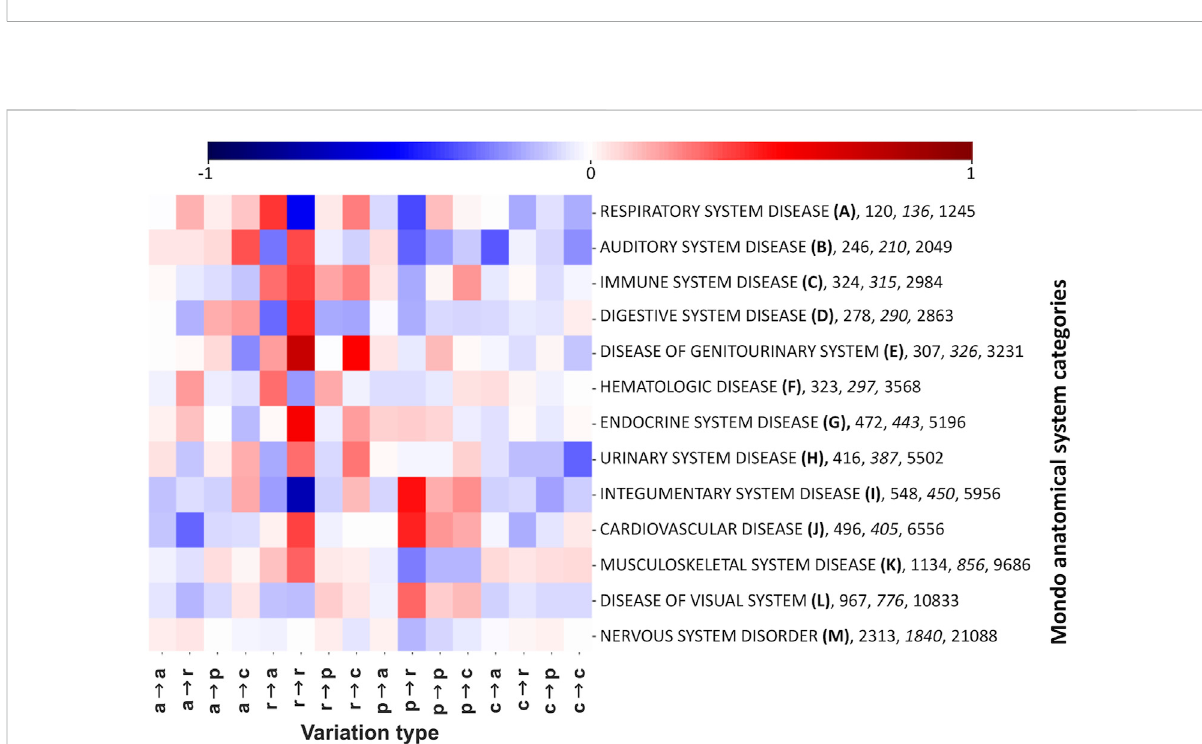
FIGURE 3 Frequency of variation types of the Union variations. Blue bars: LP/P variations; Red bars: LB/B variations. Labels are as follows: a, nonpolar; r, aromatic; p, polar; and c, charged.